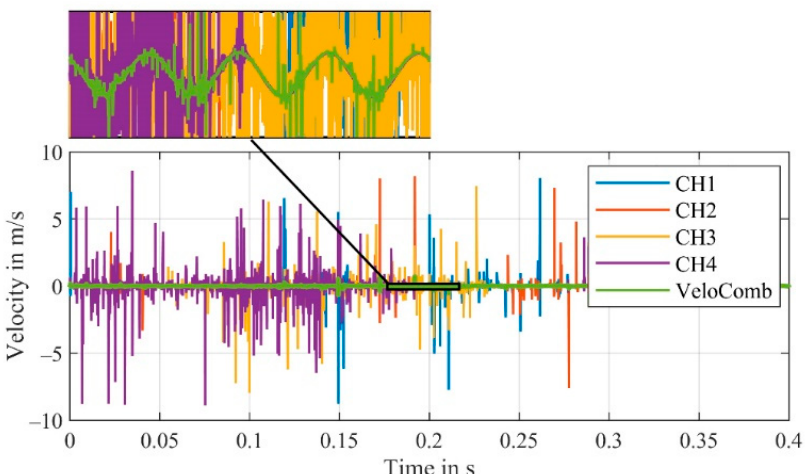
Figure 3. Velocity signals of the individual channels (CH1–CH4) and the combined velocity signal (VeloComb.); (RBW = 2.5 Hz); additional detailed view of a small section to better show the combined signal.